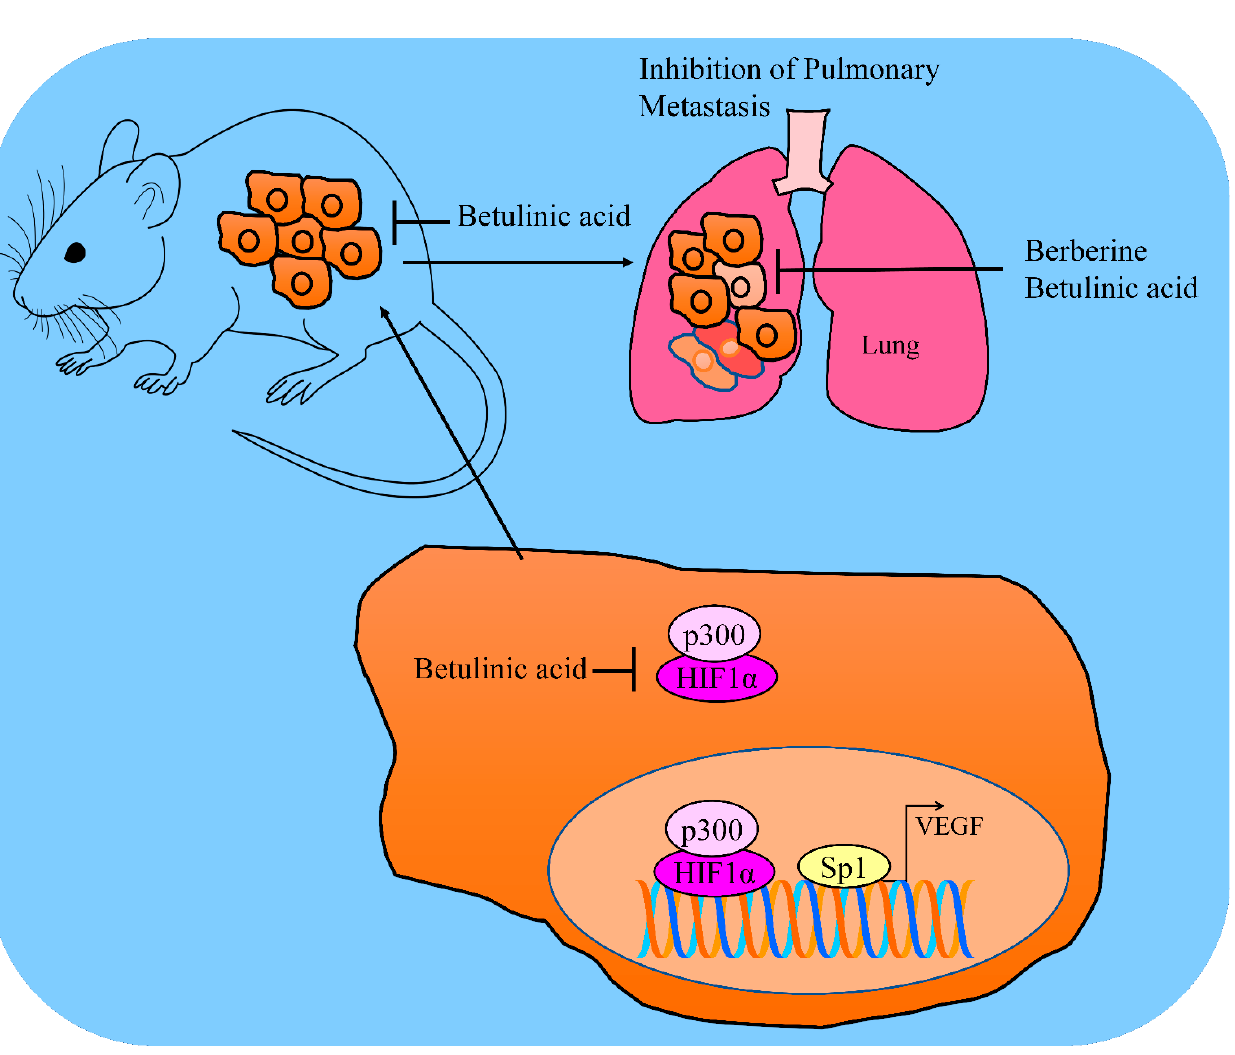
(Figure 2). Ectopic overexpression of Sp1 led to resistance against betulinic acid in PANC-1 and BxPC-3 cancer cells [35].